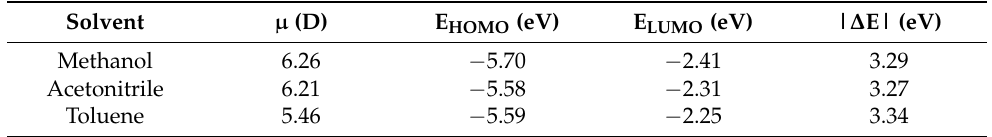
Table 2. Comparison between experimental and theoretical (calculated—DFT) signals ( δ ) for 1 H- and 13 C-NMR to the compound 7